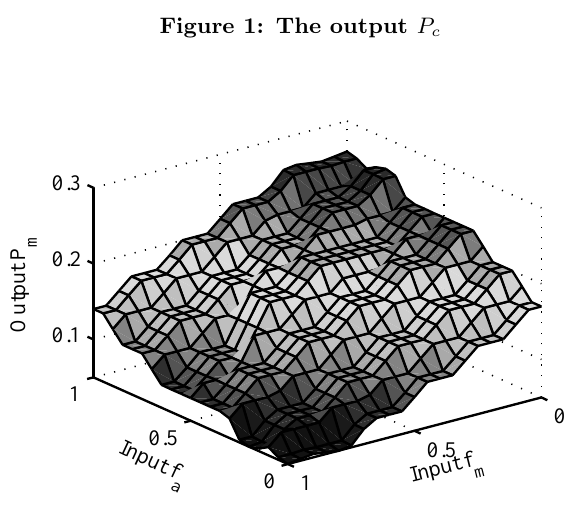
Figure 1: The output P c